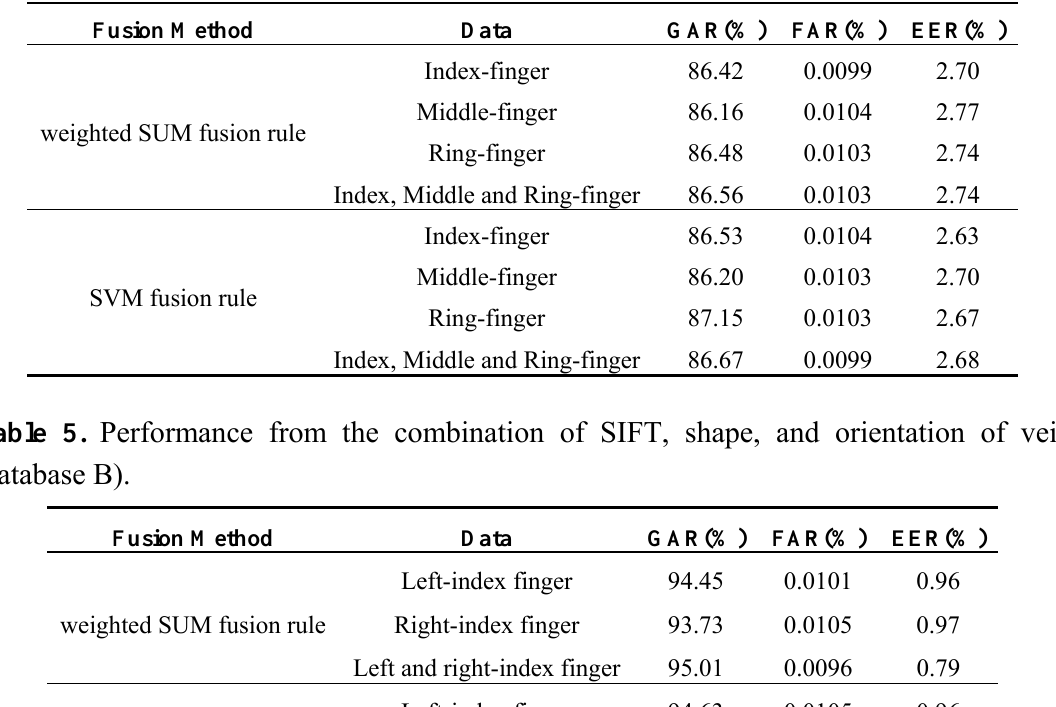
Table 4. Performance from the combination of SIFT, shape, and orientation of vein (database A).